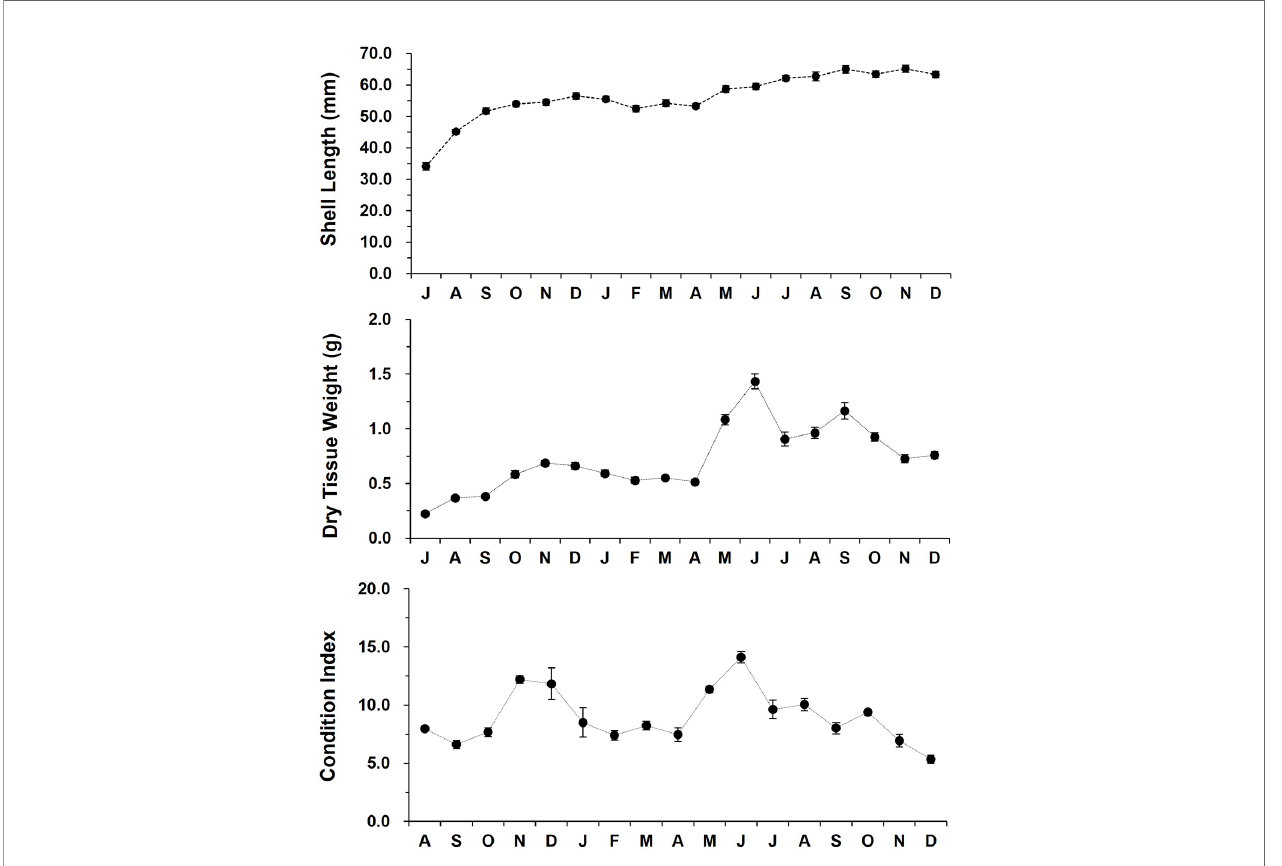
FIGURE 4 | The monthly variation in the shell length, dry tissue weight, and condition index of the off-bottom rack cultured oysters at the Euhangri beach from July 2012 to December 2013. Condition index was calculated as (dry tissue weight/dry shell weight) x